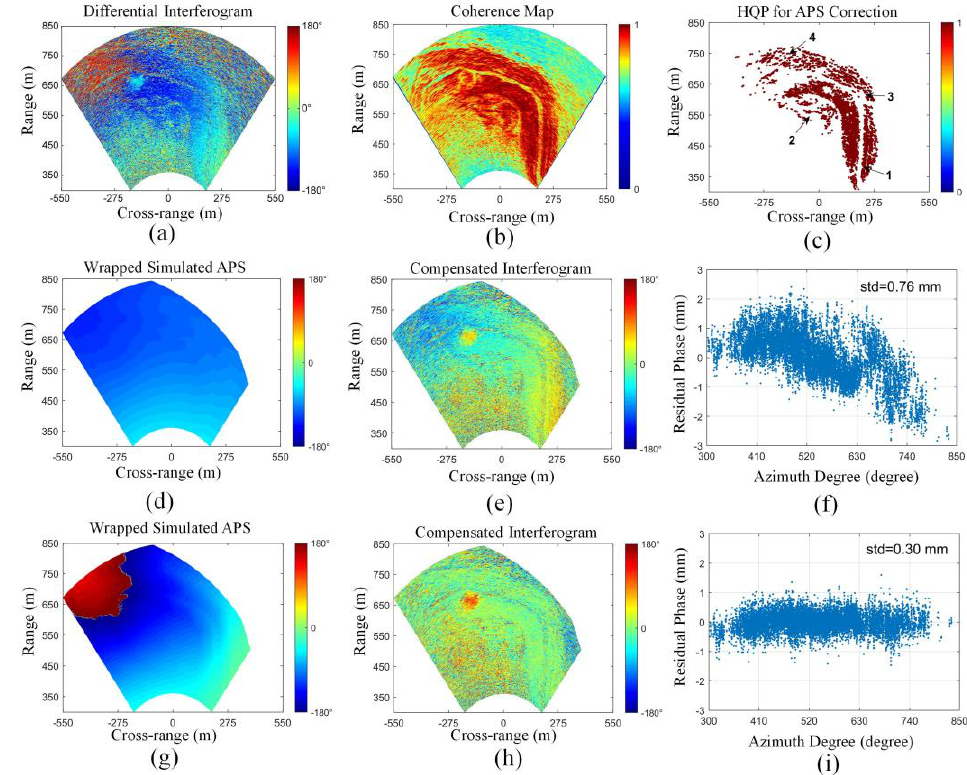
Figure 9. The validation experiment for the 3D observation scenario in the Malanzhuang open-pit. ( a ) The differential interferogram, ( b ) the coherence image, and ( c ) the selected high-quality points for APS correction. ( d – f ) show the wrapped simulated APS, the compensated interferogram, and the residual phase along the slant range of the height-related model, respectively. ( g – i ) are those of the 3D model. The height-related model has over-correction and under-correction in the upper-left part and bottom-right part in ( e ), respectively. The correction by the 3D model is more accurate due to the accurate APS simulation ( g ). The residual phase ( i ) also shows the higher accuracy of the 3D model, compared with the residual phase ( f ) of the height-related model.